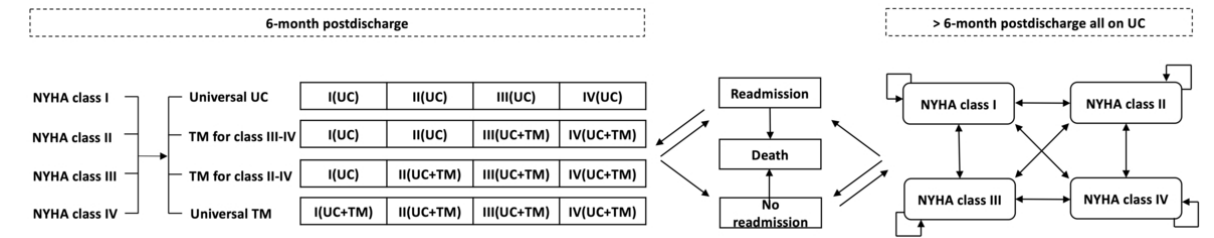
Figure 1. Simplified model structure. NYHA: New York Heart Association; TM: telemonitoring; UC: usual care; universal UC: UC only for all patients; TM for class III to IV: UC for all patients and TM for NYHA class III to IV patients; TM for class II to IV: UC for all patients and TM for NYHA class II to IV patients; universal TM: UC plus TM for all